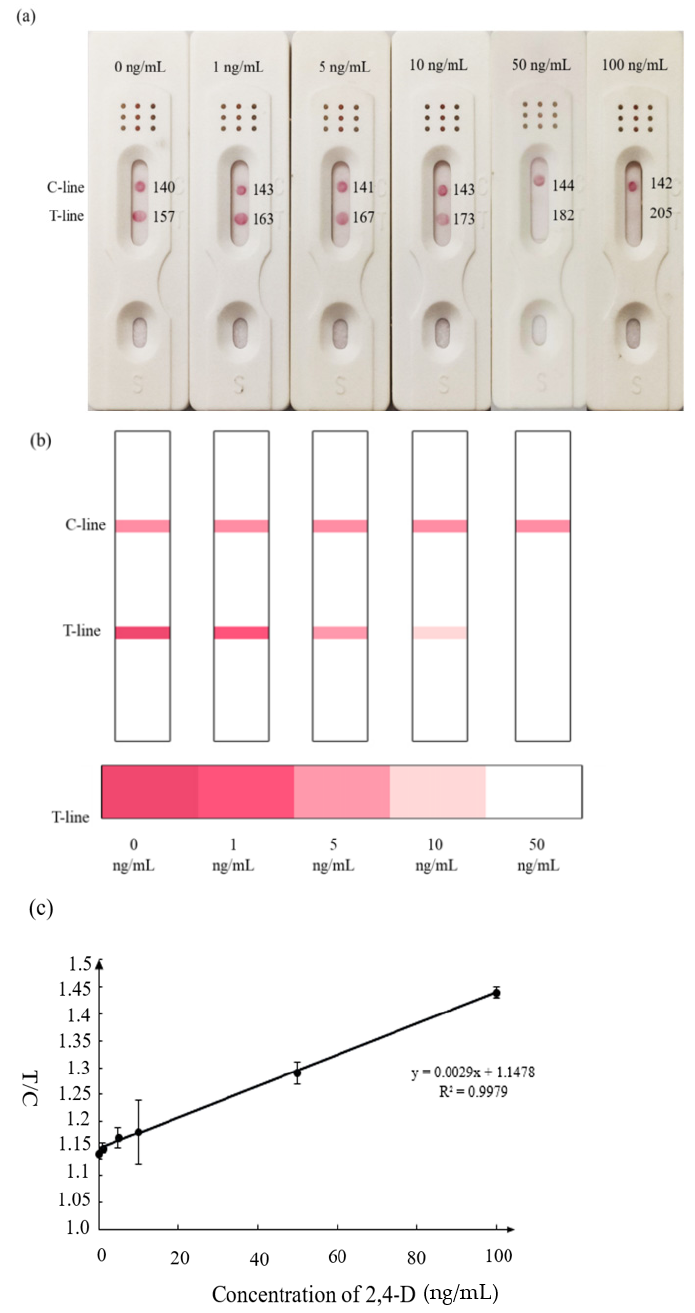
Figure 3. Determination of the visual detection limit of 2,4-D immunochromatographic test strip. ( a ) Different concentrations of 2,4-D were detected by the strips; ( b ) the simulated strips and “colori- metric card” based on the ( a ) results; ( c ) the calibration curve drawn based on the data of “Color Snap”.